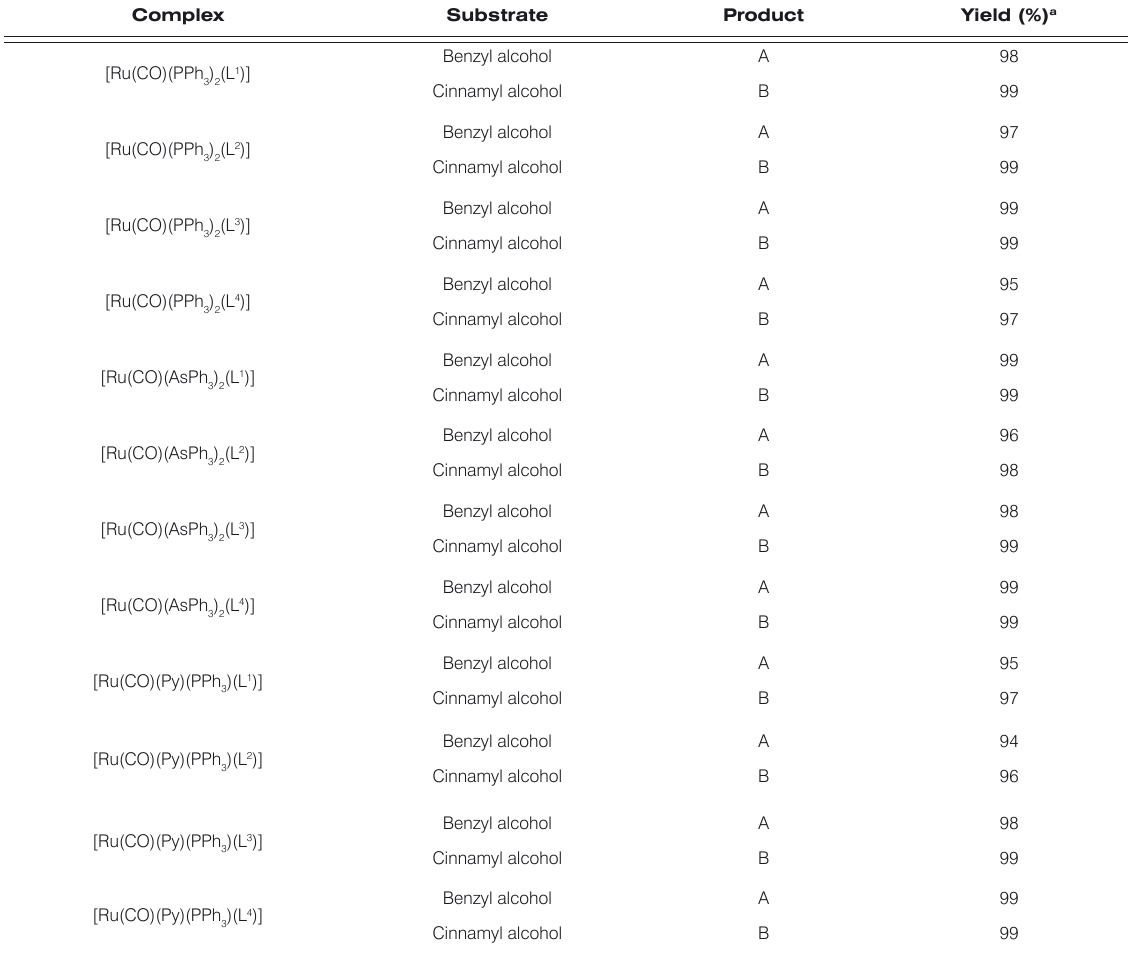
Table 6. Catalytic oxidation data of ruthenium(II) chalcone thiosemicarbazone